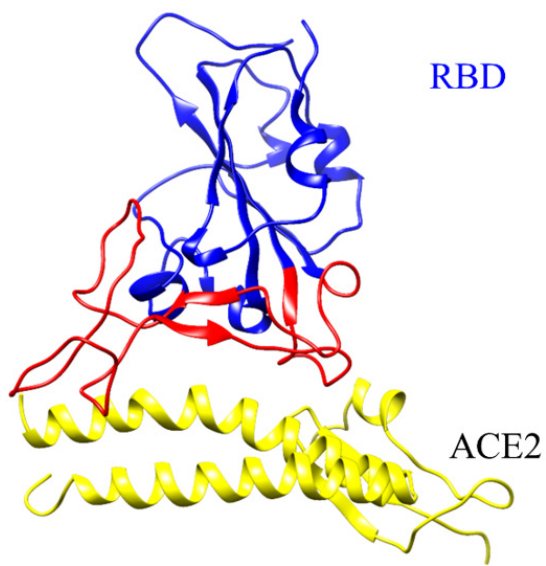
Figure 2. Interface of receptor binding domain (RBD) and angiotensin-converting enzyme 2 (ACE2). The red ribbon in the RBD is receptor binding motif (RBM).